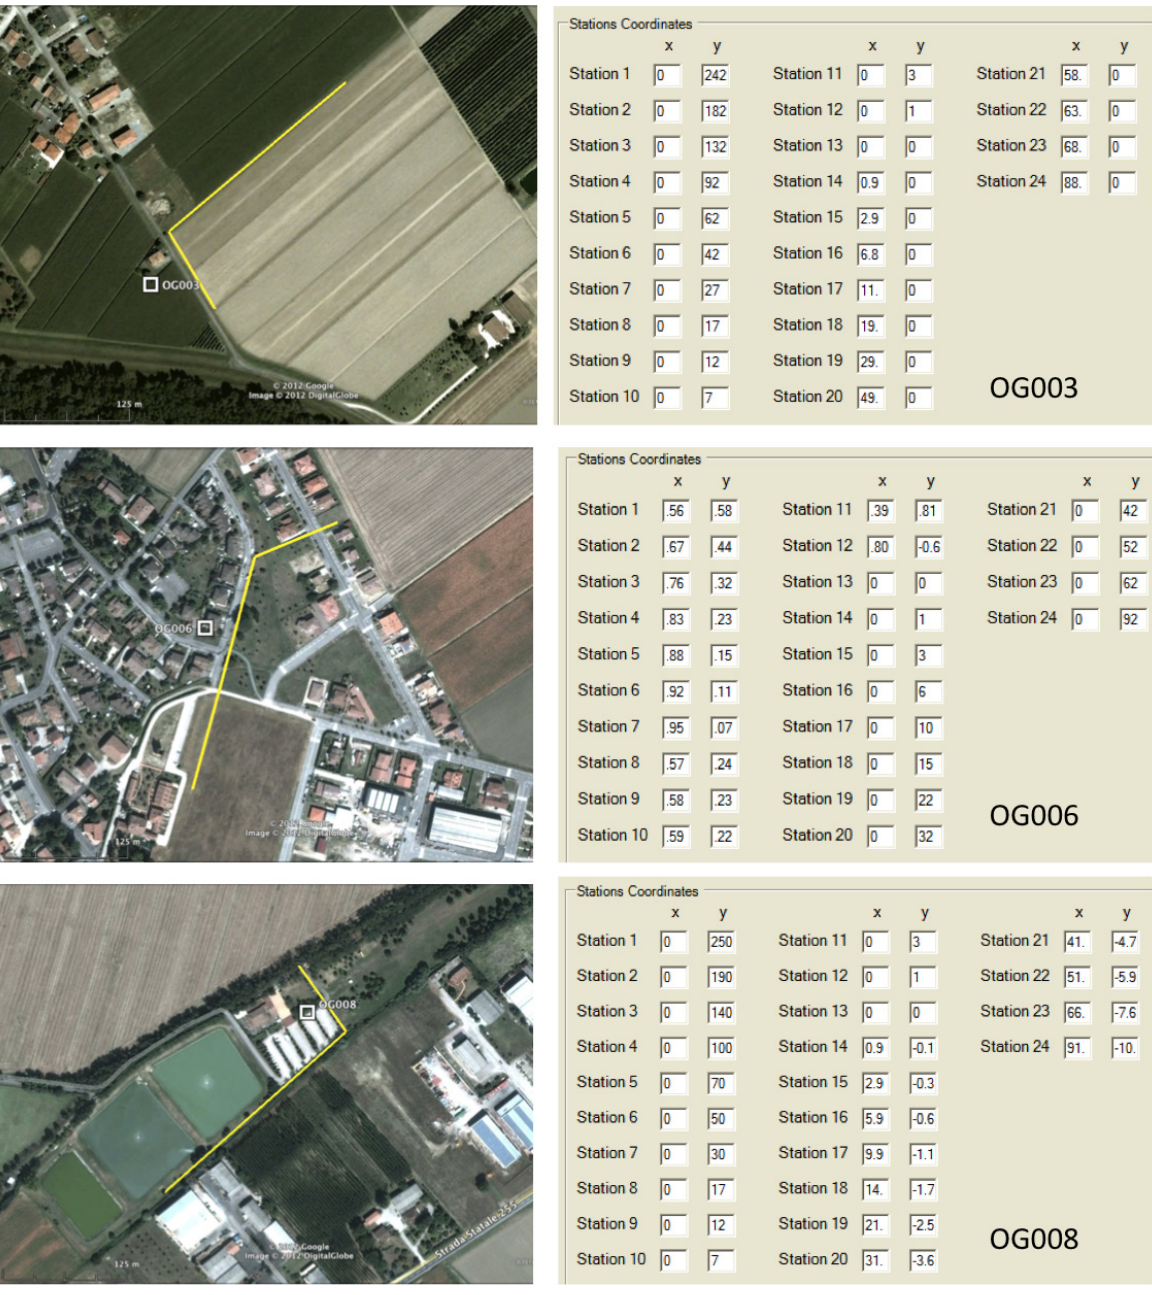
Figure 6. Array geometry (yellow lines) of the ESAC surveys performed at the OG003, OG006 and OG008 sites. For each site, a map and a list of the geo- phone coordinates are shown. The location of the temporary station is indicated by a white square in each map. The array geometry consists of two nearly orthogonal branches. The array length specified in the text is the total length of the two